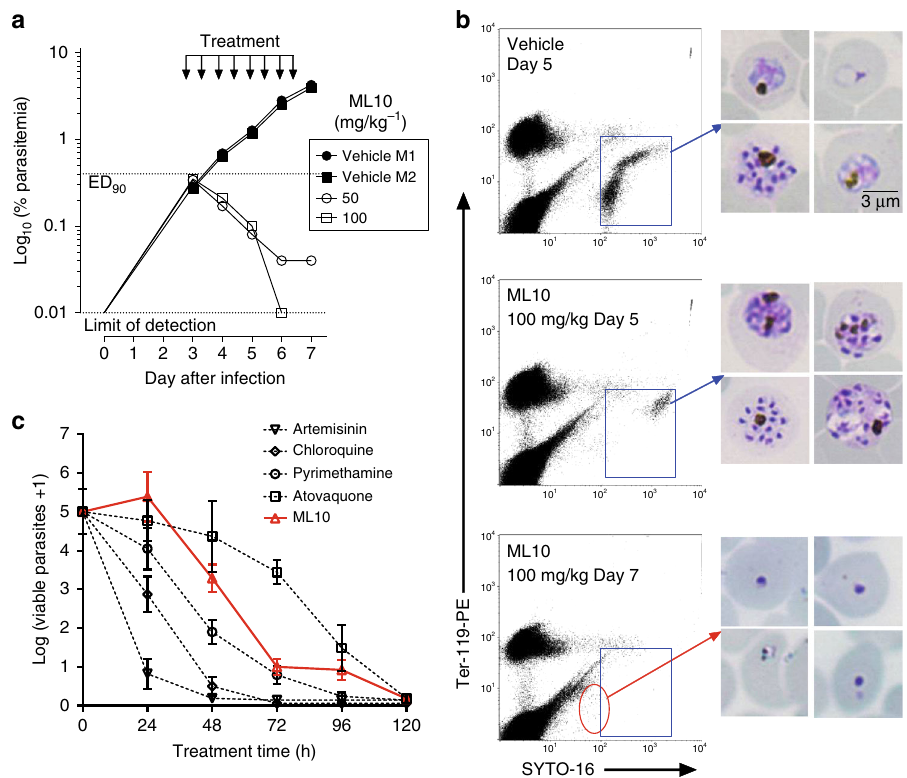
Fig. 2 Ef fi cacy of ML10 against P. falciparum in the GSK PfalcHuMouse model and determination of in vitro killing dynamics. a Two mice were treated with vehicle and another two mice with either 50 or 100 mg/kg of ML10 to test proof of concept of ef fi cacy in vivo. Parasitemia is shown over time in individual mice during the ef fi cacy assay. The dotted horizontal line indicates 90% reduction in parasitaemia compared to vehicle-treated animals. Each symbol represents an individual mouse. b Microscopic and fl ow cytometric analysis of P. falciparum present in the peripheral blood of mice treated with vehicle or ML10. Samples taken after one (48 h) and two cycles (96 h) of exposure to the test compound were further analyzed. Flow cytometry dot plots from samples of peripheral blood show P. falciparum -infected human erythrocytes ( blue rectangle ). Images in the right-hand panels show Giemsa-stained blood stage parasites. Blood fi lms from control untreated animals show normal staining and appearance. The parasites in ML10-treated animals show a relative enrichment in late schizonts at Day 5, whereas most cells remaining in peripheral blood at Day 7 are pyknotic ( red circle ). Scale bar , 3 µ m. c The in vitro parasite reduction rate ( PRR ) assay was used to determine the onset of action and rate of killing as previously described 24 . P. falciparum was exposed to ML10 at a concentration corresponding to 10× EC 50 . The number of viable parasites at each time point was determined as described 24 . Four independent serial dilutions were tested with each sample to correct for experimental variation; error bars show the standard deviation. Previous results reported on standard antimalarials tested at 10× EC 50 using the same conditions are shown for comparison